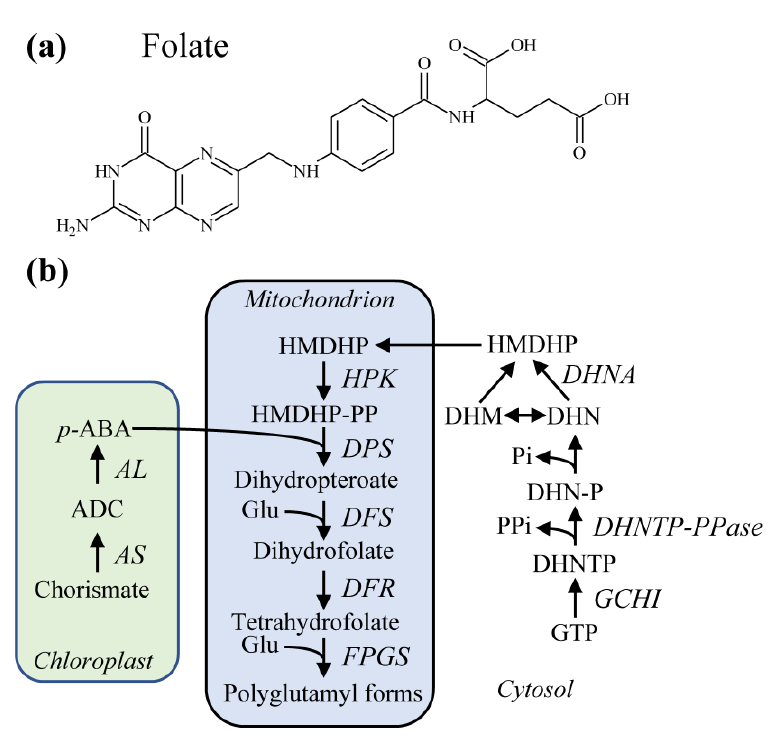
Figure 3. Folate biosynthesis in higher plants. ( a ) Chemical structure of folate. ( b ) The biosynthe- sis involves chloroplastidic, mitochondrial, and cytosolic steps. p -ABA, p -aminobenzoate; ADC, aminodeoxychorismate; AL, ADC lyase; AS, ADC synthase; DFR, Dihydrofolate reductase; DFS, Dihydrofolate synthase; DHM, dihydromonapterin; DHN, dihydroneopterin; DHN-P, dihydro- neopterin phosphate; DHNTP, dihydroneopterin triphosphate; DPS, Dihydropteroate synthase; DHNTP-PPase, DHNTP-diphosphatase; DHNA, DHN aldolase; FPGS, Folylpolyglutamate syn- thase; GCHI, GTP cyclohydrolase I; Glu, L-glutamate; HMDHP, hydroxylmethyldihydropterin; HPK, HMDHP